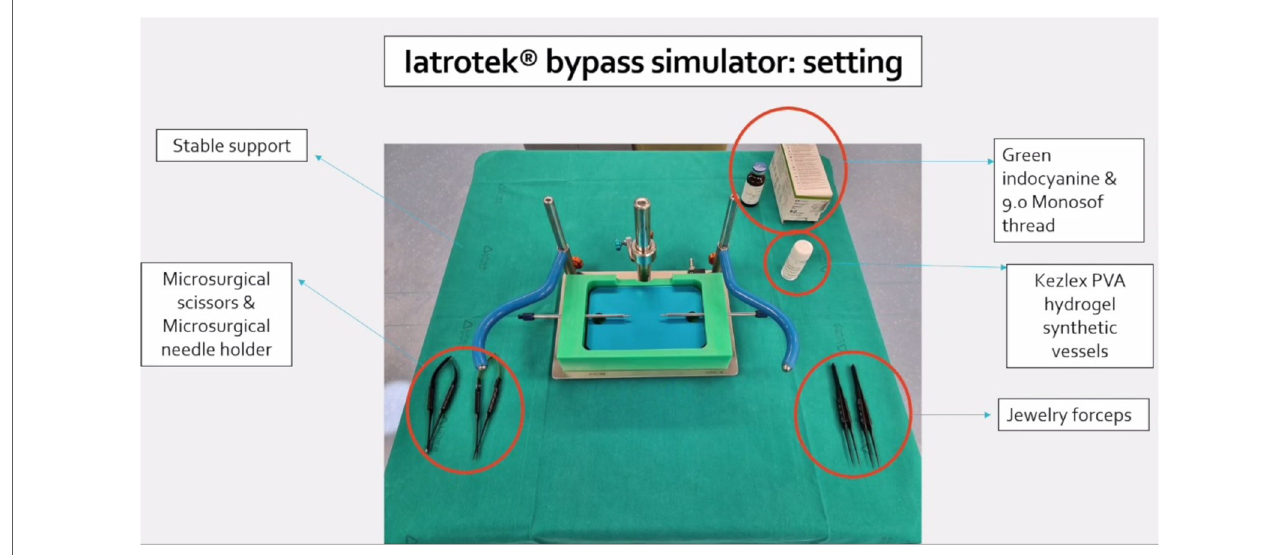
FIGURE 1 Setting of Iatrotek bypass simulator. The bypass simulator is placed on a stable support. Microsurgical scissors and needle holder are shown and tagged, together with Jewelry forceps, Kezlex Polyvinyl alcohol (PVA) hydrogel synthetic vessels, Indocyanine green and 9.0 Monosof